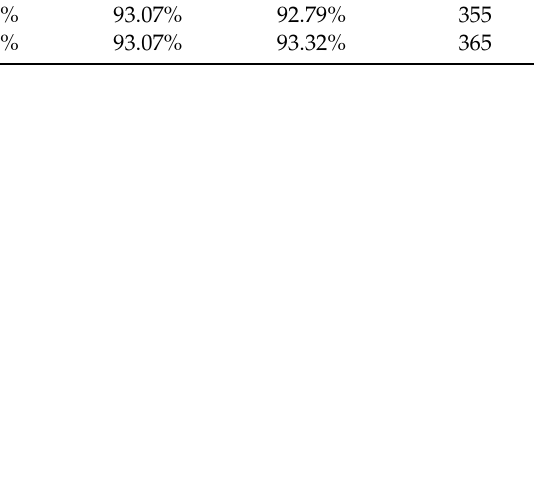
Figure 6. CNN Model Confusion